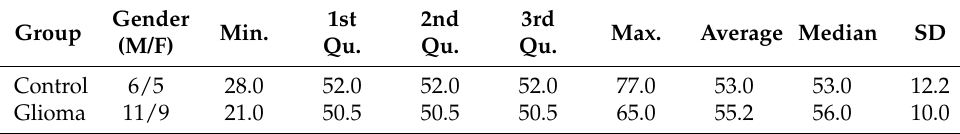
Table 4. Age and gender characteristics of control and glioma